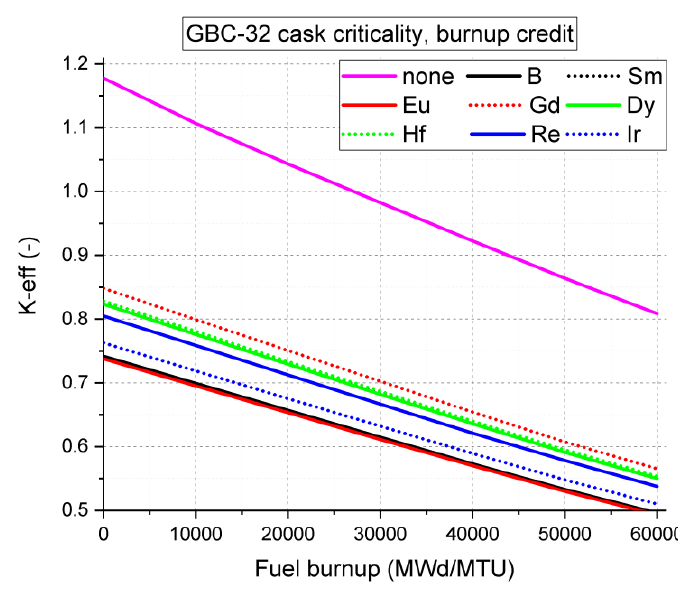
Figure 5. Burnup credit and absorber comparison.